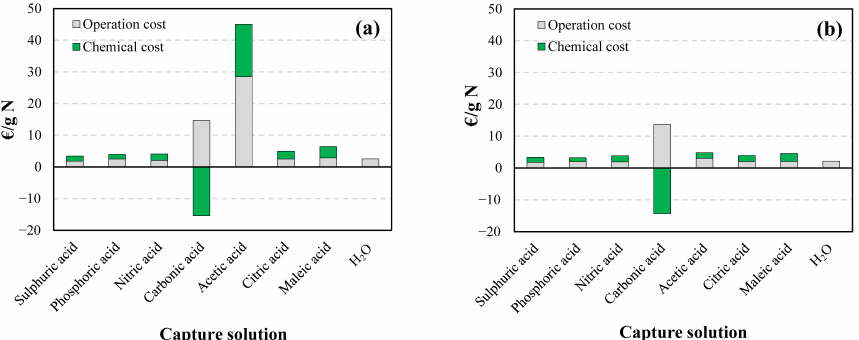
Figure 3. Economic analysis of the suspended GPM-based NH 3 capture process using eight different types of trapping solutions in the ( a ) summer (25 ◦ C) and ( b ) winter (2 ◦ C)